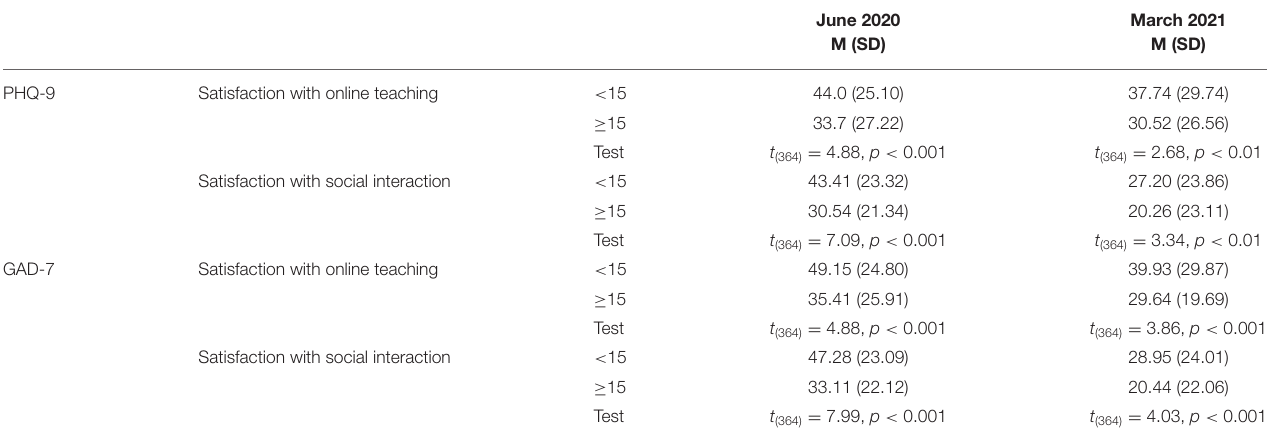
TABLE 2 | Satisfaction with online teaching and social interaction according to depressive and anxiety